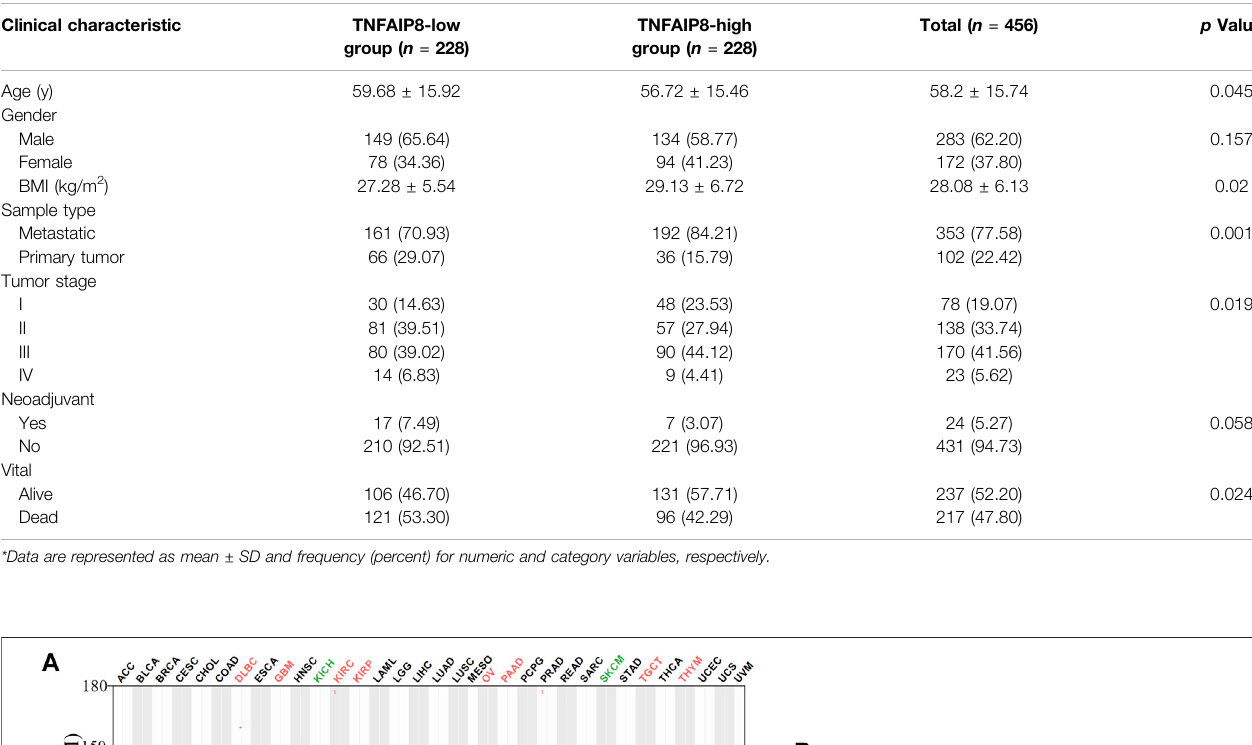
TABLE 1 | Description of clinical characteristics for 456 SKCM samples in both TNFAIP8-high and TNFAIP8-low groups from TCGA. Clinical characteristic